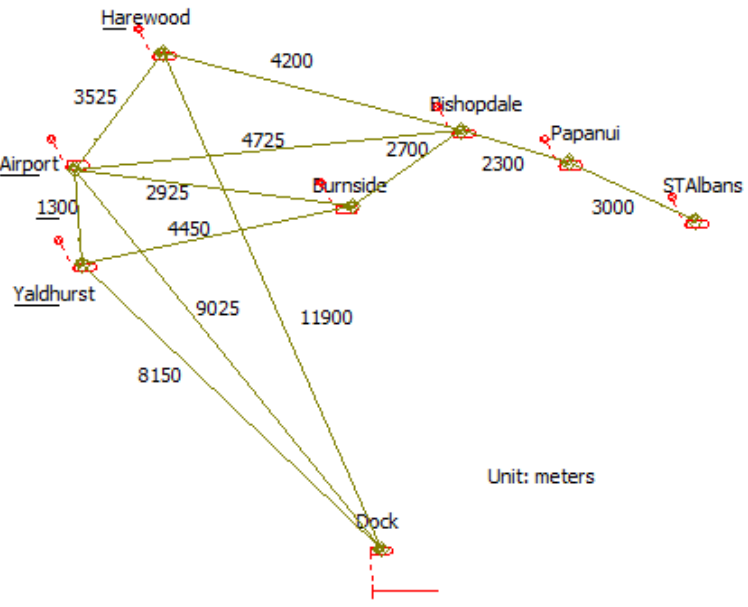
Figure 5. Transport network of simple suburb cluster